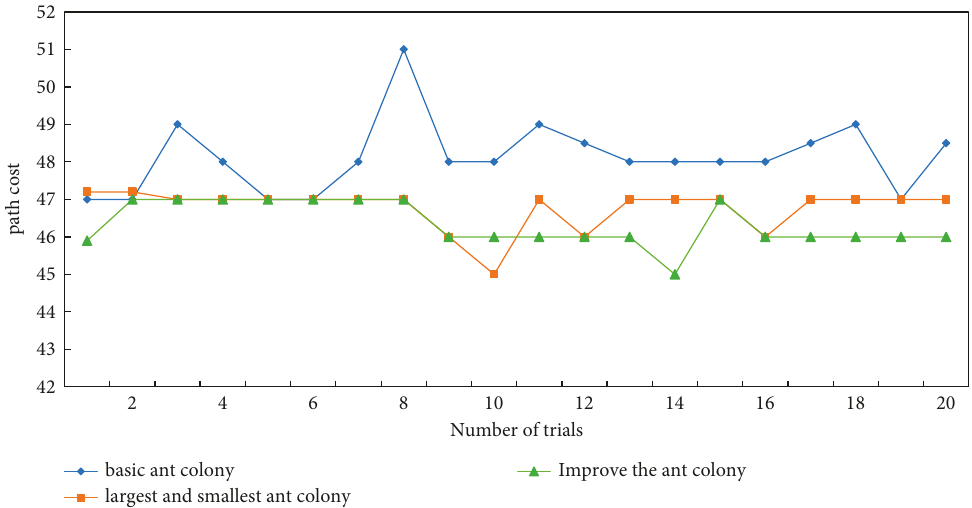
Figure 7: Path cost diagram of each ant colony